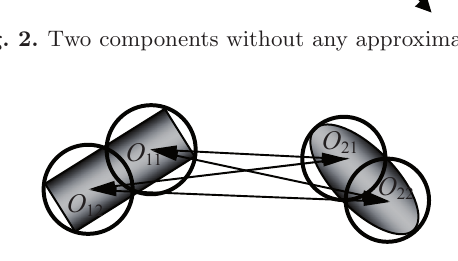
Fig. 3. Simplified geometry constraints with FCM.